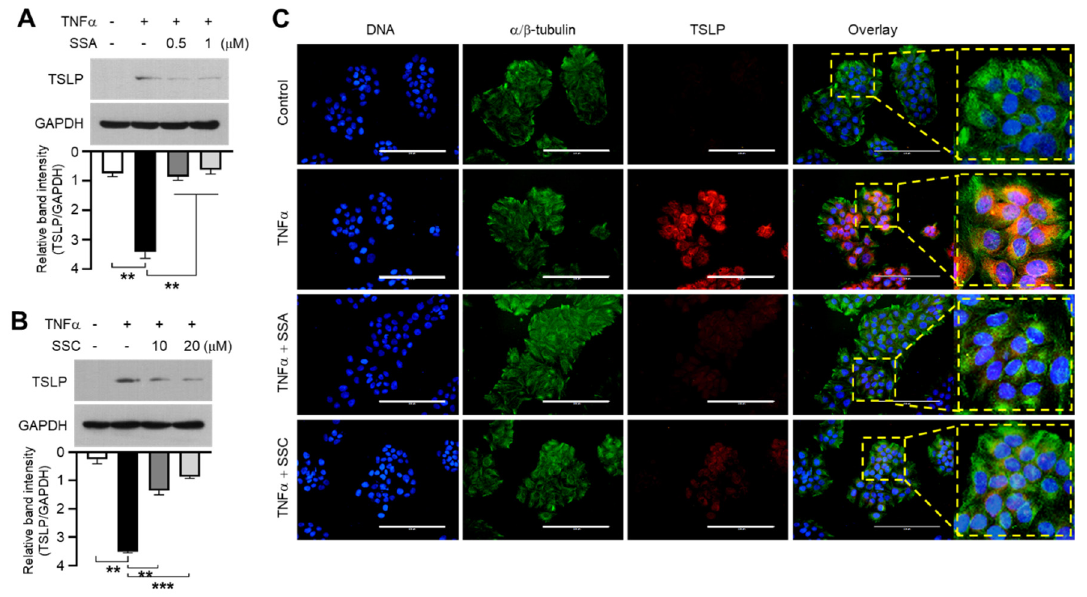
Figure 3. SSA and SSC decrease TNF- α -induced increase in TSLP protein levels in HaCaT cells. ( A , B ) HaCaT cells were pretreated with 0.5 or 1 µM SSA ( A ) and 10 or 20 µM SSC ( B ) for 30 min before treatment with 10 ng/mL of TNF- α . After 24 h, TSLP protein levels were measured by immunoblot analysis. The band intensities corresponding to TSLP levels were normalized to those of GAPDH levels using ImageJ software. The quantitation data are presented as means ± SD ( n = 3). ** p < 0.01 *** p < 0.001 by Sidak’s multiple comparisons test. ( C ) HaCaT cells, cultured on coverslips, were treated with TNF- α (10 ng/mL) for 24 h in the absence or presence of SSA (1 µM) or SSC (20 µM), and immunofluorescence staining was performed using anti-TSLP (red) and anti- α / β -tubulin (green) antibodies. Nuclei were counterstained using 1 µg/mL Hoechst 33258 (blue). Scale bars, 200 µm.